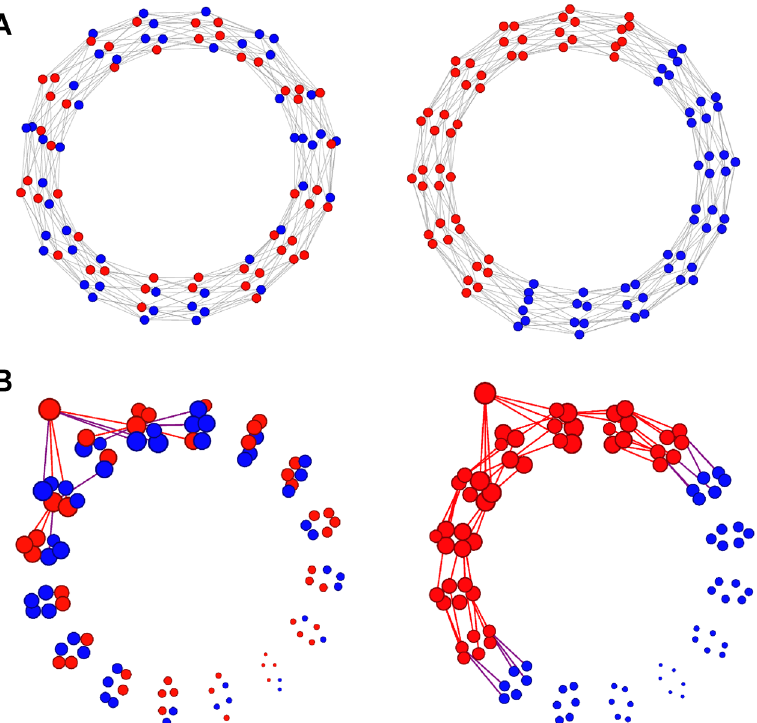
Figure 1. Experimental design. ( A ) Subjects were randomly assigned to either an ideologically integrated (left) or segregated network (right) in which red (blue) nodes represent self-identified conservative (liberal) participants ( N = 96, degree = 6). ( B ) Each diffusion process (16 networks × 32 messages = 512 in total) was initiated by a random seed node, who received an ideologically aligned message, and had it automatically shared with their 6 neighbors. We show the observed propagation history of a false conservative-leaning message under ideological mixing (left) and homophily (right). Node size decreases with the shortest distance (1–8) to the seed